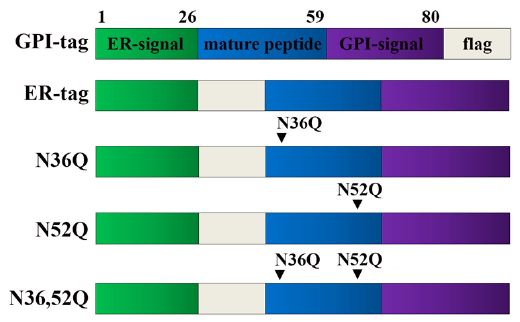
Figure 2. Schematic presentation of the different constructs used. For details on CD24 molecule and constructs, see text .